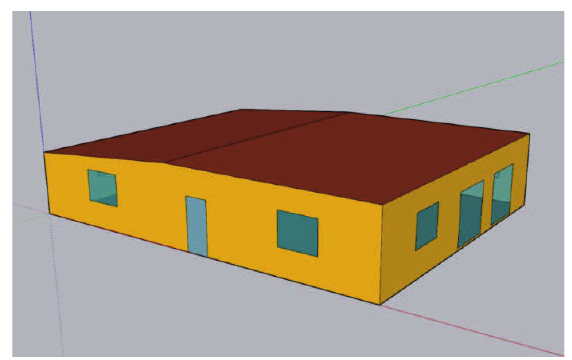
Fig. 1. SketchUp model of the building.